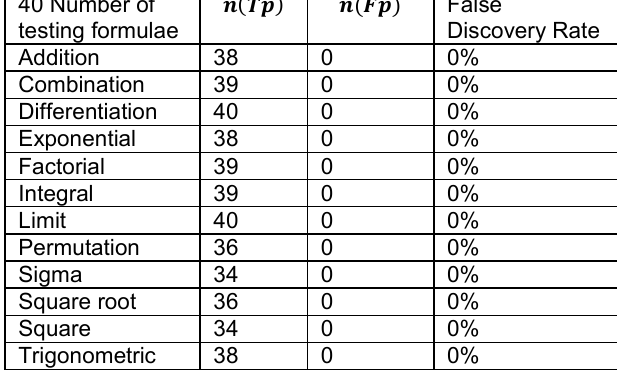
Table 17. The above tabulated value represents overall FDR Measure with Tensorflow from a document of 40 samples.